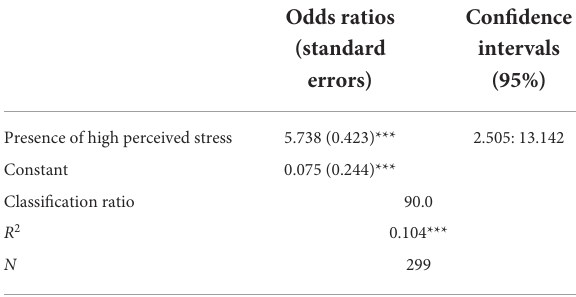
TABLE 4 Multiple binary logistic regression of the presence of dangerous drinking